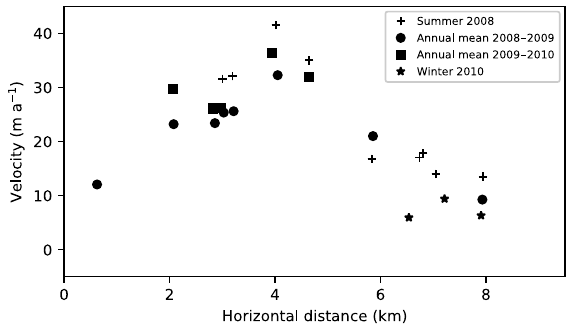
Figure 3. Measured ice surface velocities along the CL.